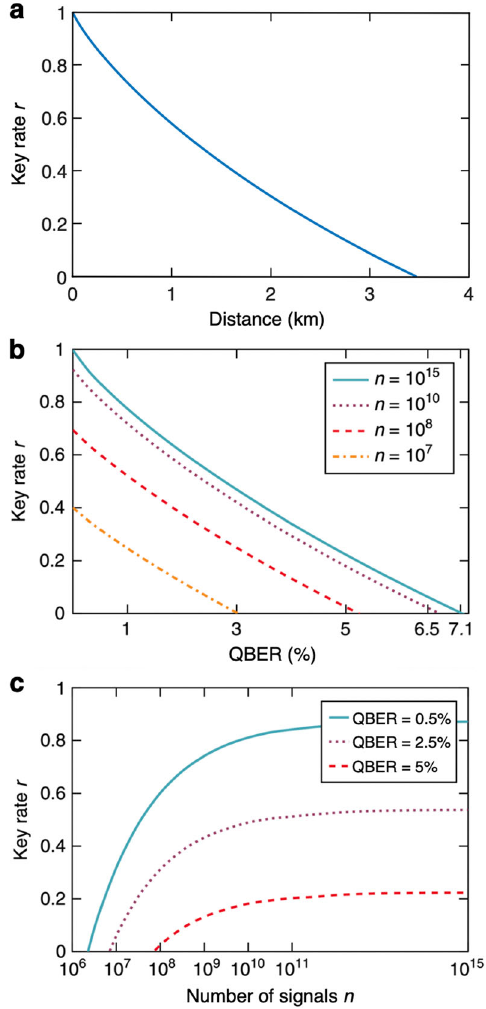
Fig. 3 Secret key rate performance of DI-QKD. a Asymptotic DI Devetak-Winter secret key rate as a function of the distance 115 – 117 . An idealized scenario is assumed where Alice and Bob implement unit ef fi ciency measurements on their shares of a perfect Bell pair, delivered by an entanglement source equidistant from both of them. Moreover, the standard approach where undetected signals are mapped to a fi xed outcome is presumed for the closure of the detection loophole. Noticeably, even in this idealized setup, the absence of a heralding mechanism implies that the distance covered by DI-QKD is below 3.5 km, considering an attenuation coef fi cient of 0.2 dB/km (referred to the third telecom window). The limited-ef fi ciency model is considered for the channel loss 36 . b , c Finite secret key rate as a function of the QBER and the number of transmitted signals, n , assuming a depolarizing-noise model for a perfect Bell pair and no losses of any kind. For illustration purposes, some typical fi nite-key parameters are selected. Both fi gures, b and c, are reproduced from ref. 40 under the Creative Commons